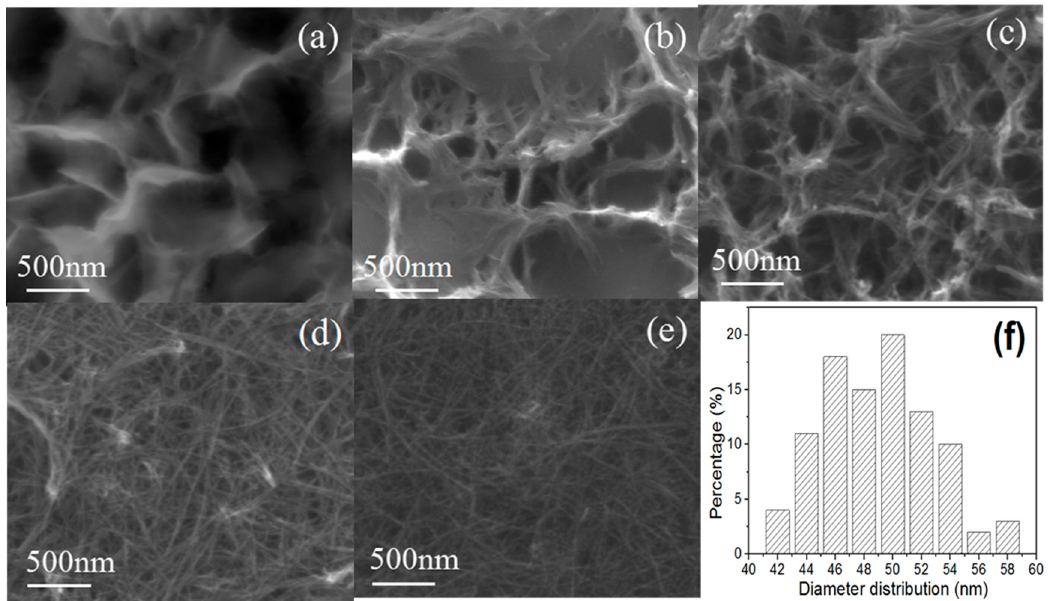
Figure 4. SEM micrographs of TiO2 nanotubes prepared at the different concentration of NaOH. ( a ) 1 mol/L; ( b ) 3 mol/L; ( c ) 5 mol/L; ( d ) 7 mol/L; ( e ) 10 mol/L; ( f ) the size distribution of TiO 2 nanotubes